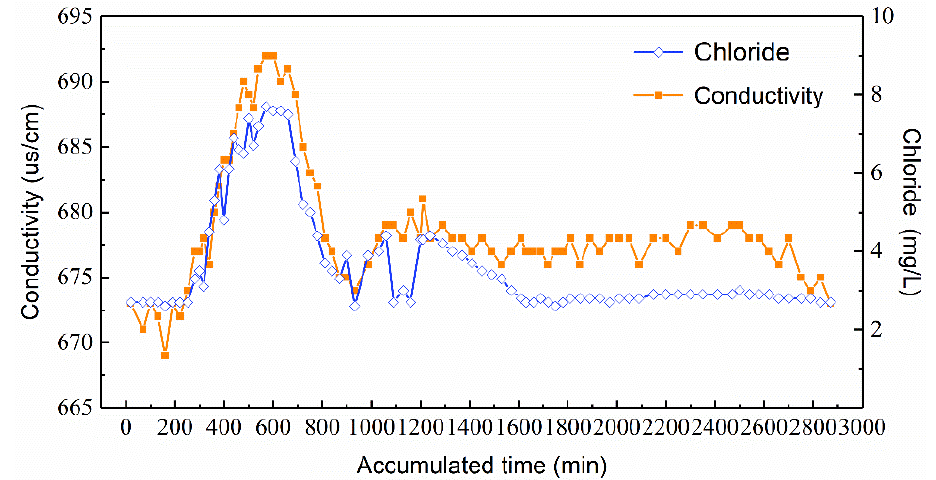
Figure 11. Changes in the conductivity and concentration of chloride.